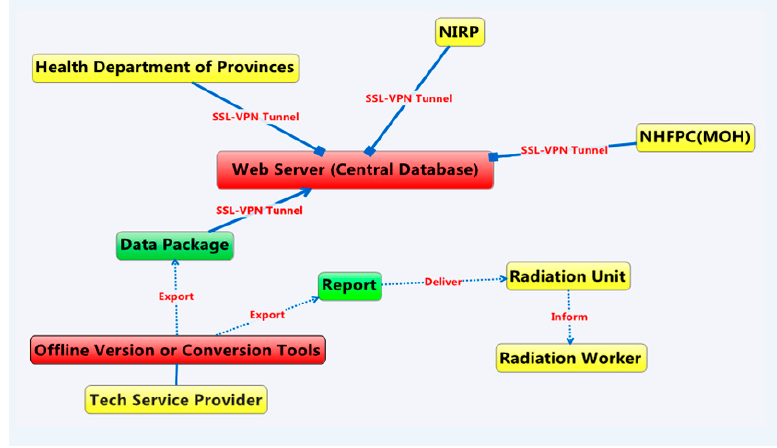
Figure 1. Structure of China Register of Radiation Workers (CRRW) System: PC version + web version.